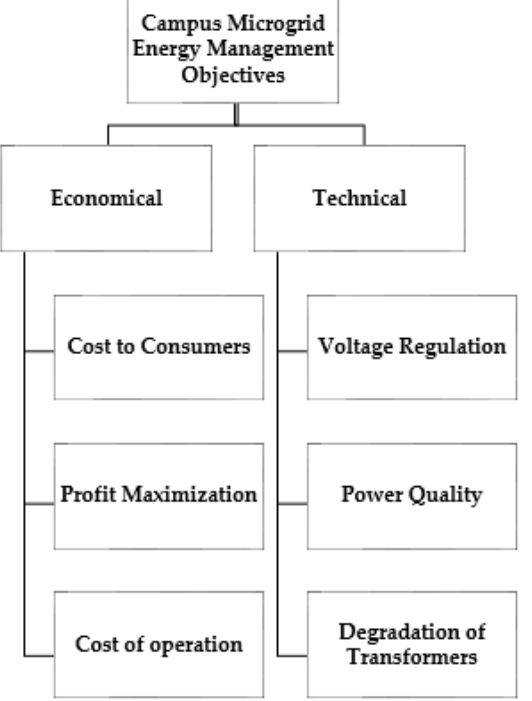
Figure 4. Important objectives of energy management in campus microgrids.